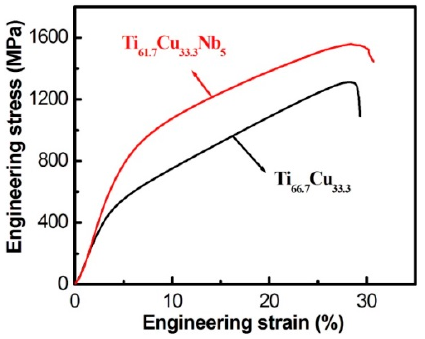
Figure 5. The compressive stress–strain curves of the Ti 66.7 Cu 33.3 and Ti 61.7 Cu 33.3 Nb 5 alloys.